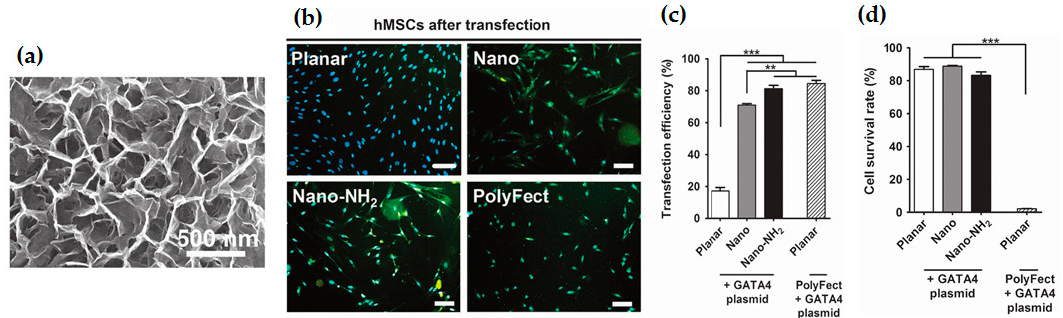
Figure 6. ( a ) SEM image of the silica upright nanosheet network; Fluorescent images ( b ) and the corresponding transfection efficiency ( c ) of human mesenchymal stem cells (hMSCs) after transfection with GATA4 plasmid on a planar silica surface (Planar), unmodified nanosheets (Nano), amino-modified nanosheets (Nano-NH 2 ) and with the transfection agent PolyFect on the planar surface (Polyfect) (the scale bar represents 50 µ m); ( d ) Cell survival rate of hMSCs, determined by flow cytometry, at 60 h post seeding (and 84 h in the Polyfect group). Reproduced from [31], with permission from Springer Nature.